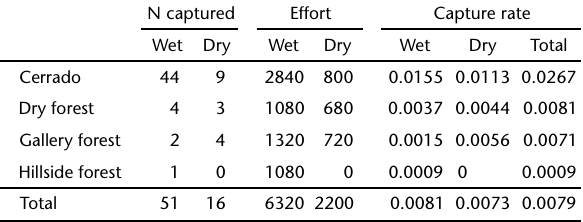
Table I. Number of specimens of M. maximiliani captured in pitfall traps at Estação Ecológica Uruçuí Una in the wet and dry seasons. The sampling effort expended (in buckets x days) and capture rate (individuals per bucket) in each season are presented.